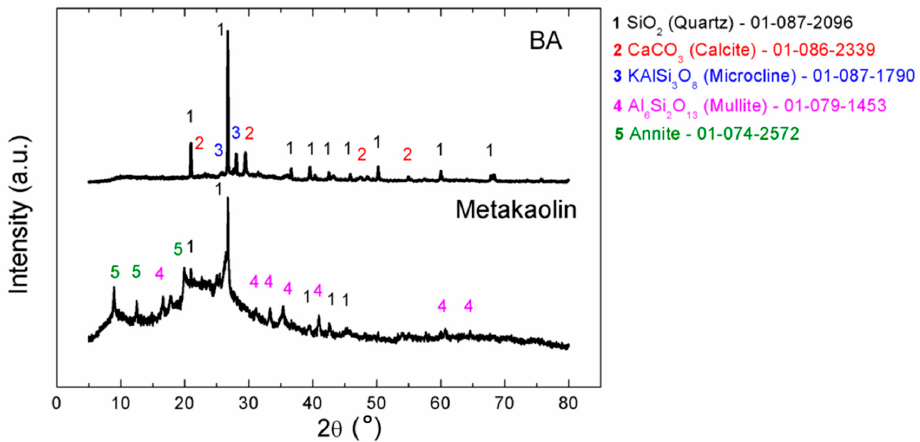
Figure 2. Diffractograms of BA and Metakaolin.